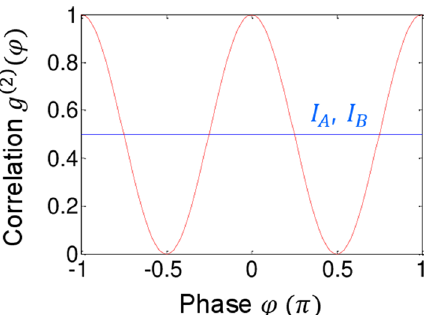
Figure 2. Numerical calculations for intensity correlation g ( 2 ) (ϕ) . The phase ϕ is within coincidence detection ϕ ζ , ζ ′ . The blue line is a classical lower (cid:30) ∈ (cid:31)